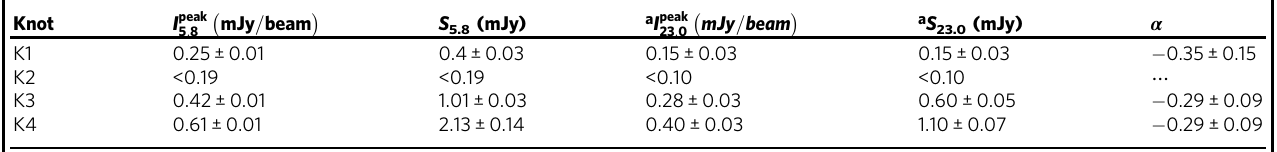
a Fluxes taken from ref. 22 . The source of uncertainties is coming from measurement uncertainties